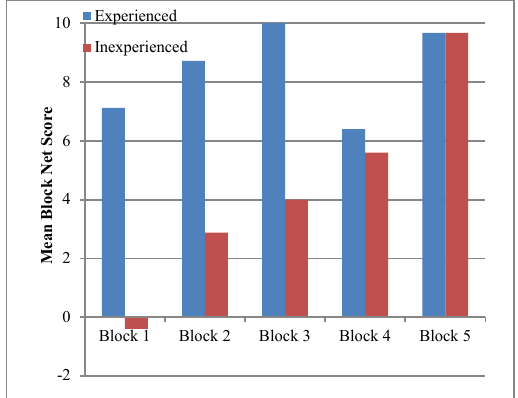
Fig. 4. Mean block net score of experienced and inexperienced group